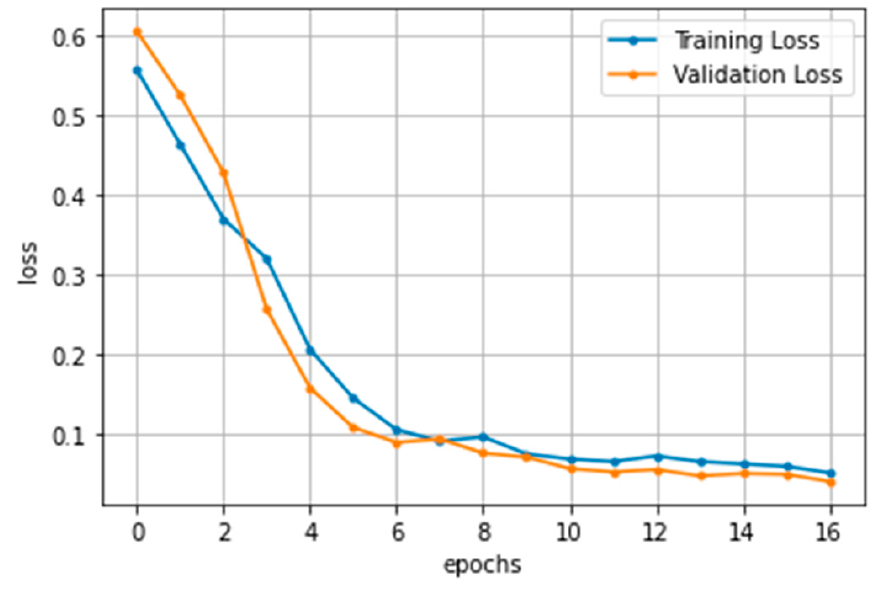
Figure 10. Training and validation loss of CNN model.